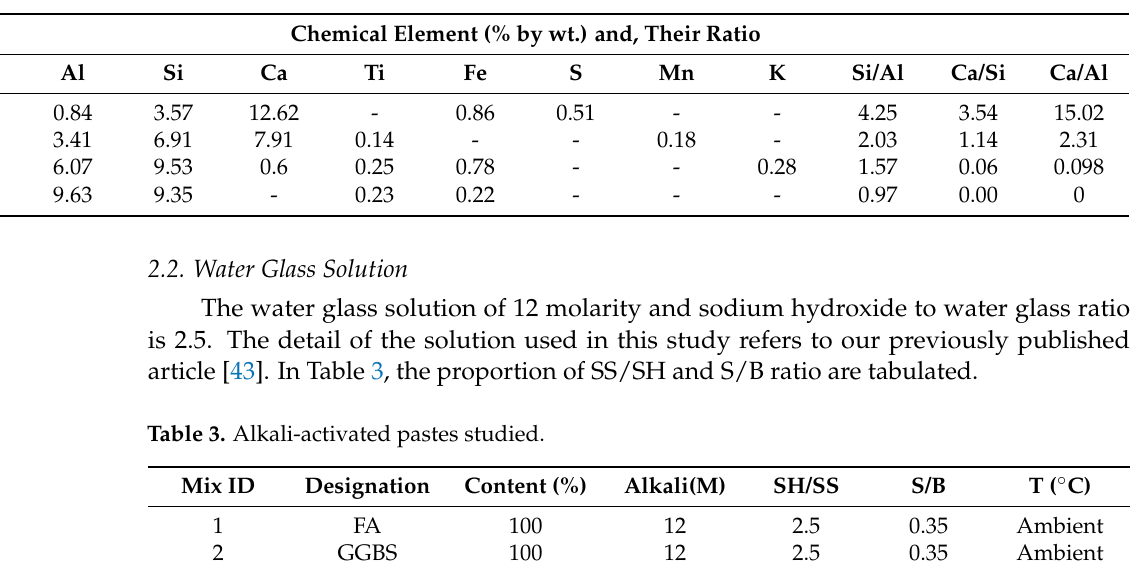
Table 2. EDX elements composition of aluminosilicate